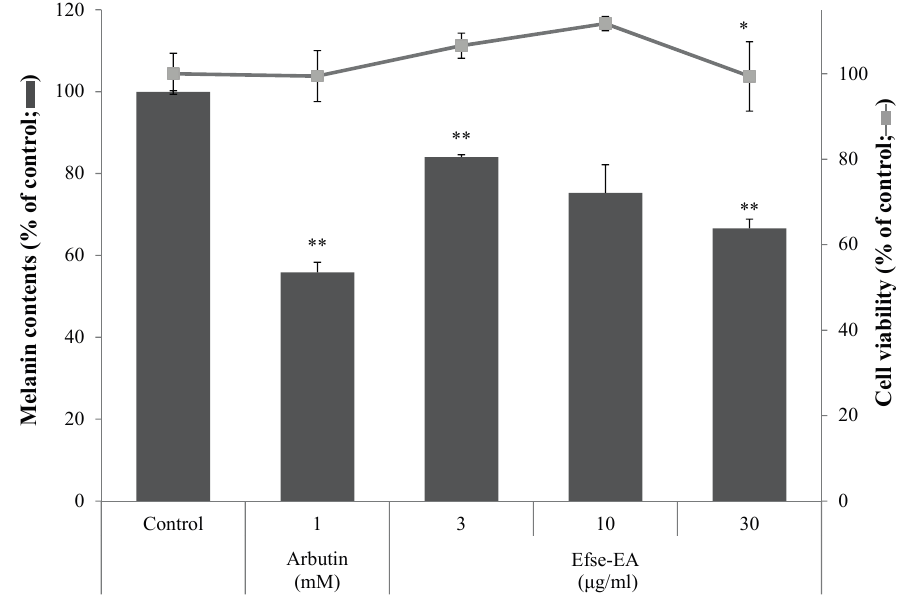
Figure 3. Effect of Efse-EA on melanogenesis in melan-a cells. Cells (1 × 10 5 cells/mL) were seeded for overnight, and then the medium was replaced with fresh medium containing the indicated concentrations of Efse-EA or PTU ( N -phenylthiourea). Cells were cultured for 72 h and further incubated for 24 h. After washing with PBS, the cells were lysed with 250 μ L of 1 N NaOH and transferred to a 96 well plate. The melanin contents were estimated by measuring the absorbance at 405 nm. Each determination was made in triplicate and the data shown represent the mean ± SD. * p < 0.05, ** p < 0.01, Student’s t